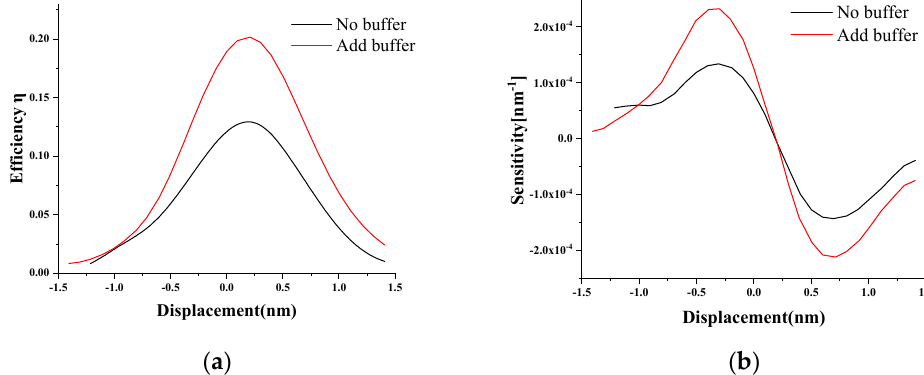
Figure 6. ( a ) The coupling efficiency. ( b ) The sensitivity with the displacement of the cantilever for the conventional structure and the improved structure with a buffer.